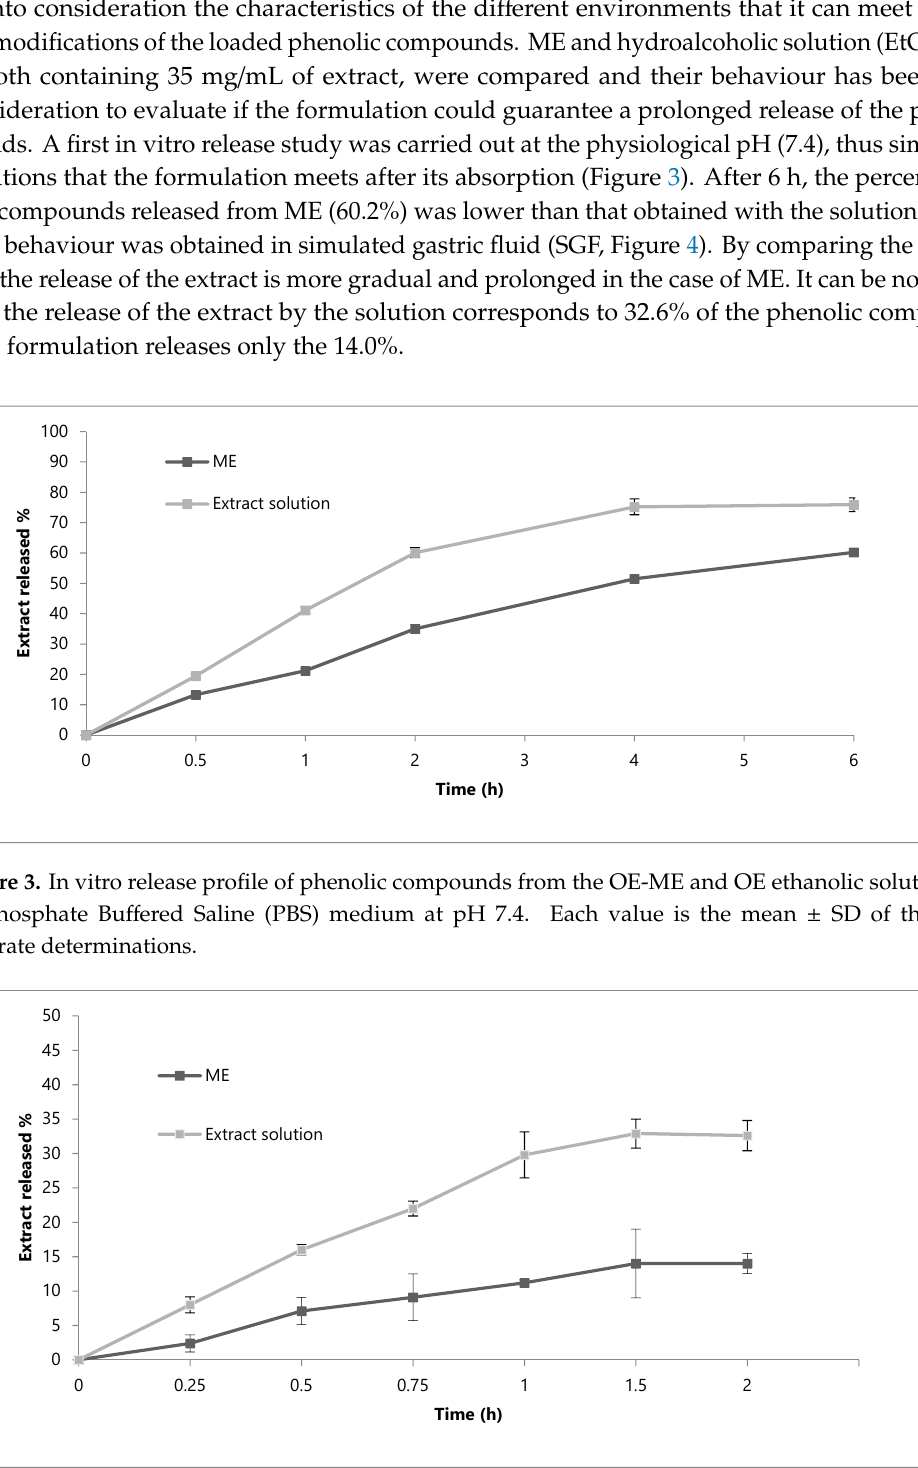
Figure 4. In vitro release profile of phenolic compounds from the OE ‐ ME and OE ethanolic solution in Simulated Gastric Fluid (SGF) medium at pH 1.2. Each value is the mean ± SD of three separate determinations.